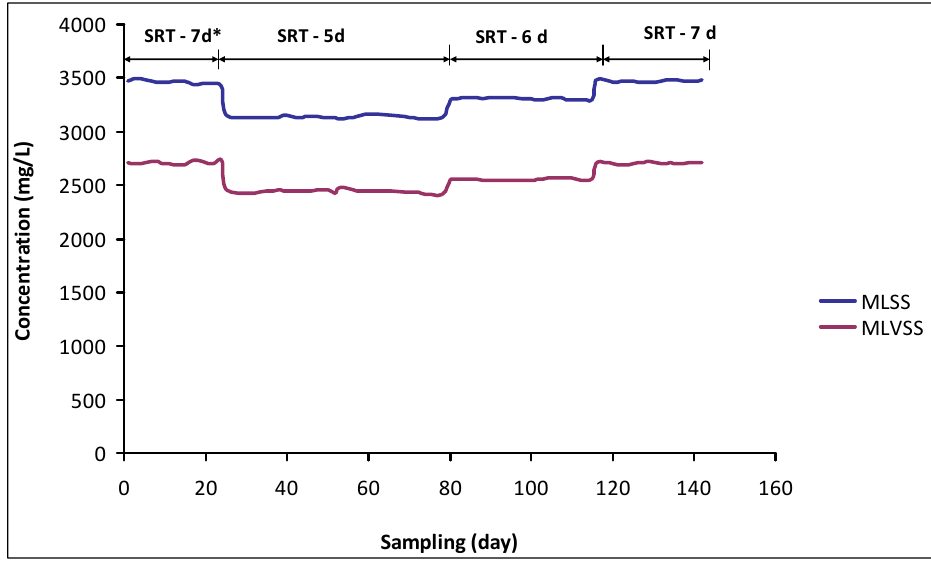
Figure 4. Variation of sludge volume index (SVI) during the study period.